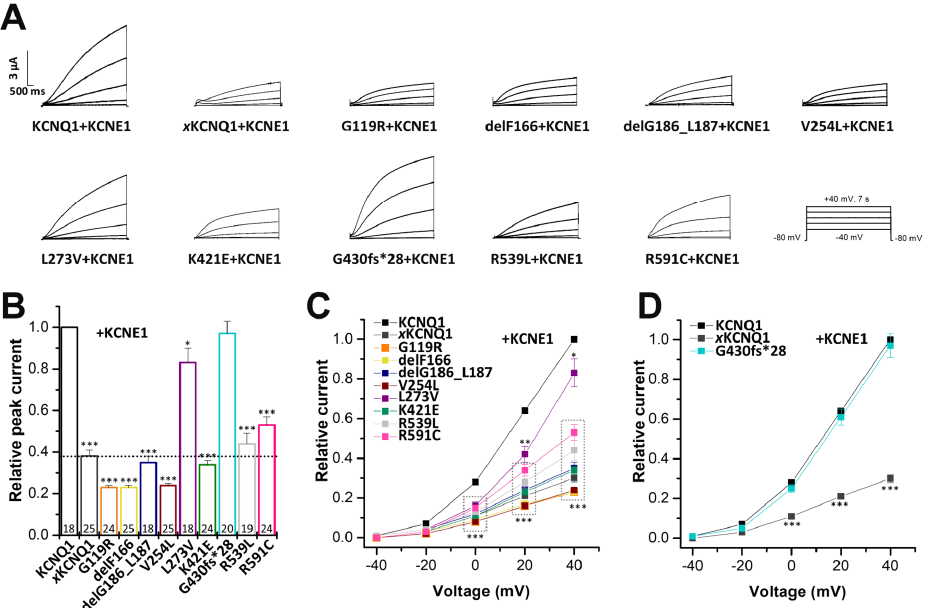
Figure 5. Electrophysiological properties of KCNQ1 variants co-expressed with KCNE1. ( A ) Xenopus laevis oocytes were injected with 81.2 ng wild-type KCNQ1 cRNA or the indicated mutant KCNQ1 cRNA, and all constructs were co-injected with 1 ng of KCNE1 cRNA. In addition, some oocytes were injected with 1 ng KCNE1 alone to quantify the amplitude of the endogenous xI Ks . Voltage was stepped to potentials ranging from − 40 to +40 mv in +20 mV steps lasting for 7 s, each starting from a holding potential of − 80 mV. The voltage protocol is indicated on the right bottom corner. Representative current traces for wild-type KCNQ1 plus KCNE1, x KCNQ1 plus KCNE1 or the indi- cated mutants plus KCNE1 are shown. ( B ) Current amplitudes analyzed at +40 mV and normalized to wild-type KCNQ1 plus KCNE1. All the data, including that of the wild-type recordings, were divided by the average current amplitude of the wild-type at +40 mV of the respective recording day. Numbers of oocytes are indicated within the bar graph. ( C ) Current-voltage relationships obtained by plotting the current at the end of each voltage step for each voltage applied normalized to wild-type KCNQ1 plus KCNE1. In order to obtain the current-voltage relationship (I/V curve), all wild-type recordings were normalized to the value at +40 mV. The data of all the other constructs were also divided by the average current amplitude of the wild-type at +40 mV of the respective recording day. KCNQ1 variants with a significant current reduction are illustrated in ( C ) and a variant with no significant effect in ( D ). Values are expressed as means ± S.E.M. Error bars represent S.E.M. values. Significance was assessed using two-tailed Student’s t -test. Asterisks indicate significance: *, p < 0.05; **, p < 0.01; ***, and p <